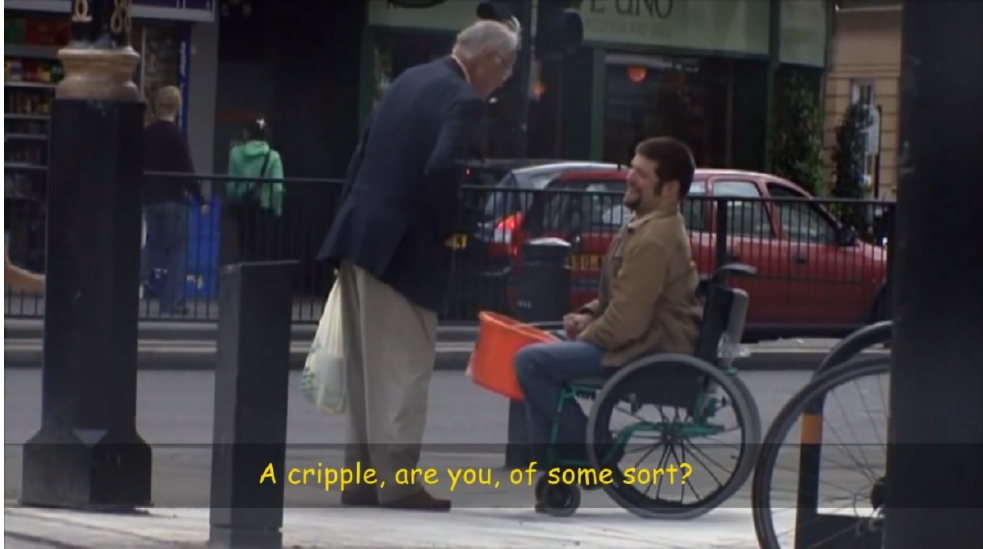
Figure 2. An older passerby asks Laurence Clark whether he is “a cripple” and drops money into the comedian’s charity bucket, which is labelled “KILL THE PUPPIES!”. Reproduced under the permission of fair dealing; copyright Clark 2011.